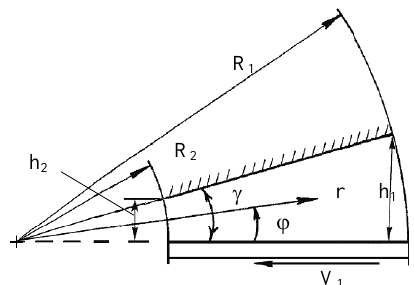
Figure 8. Analytical model to simulate the speed mode of the vortex cavitation facility.